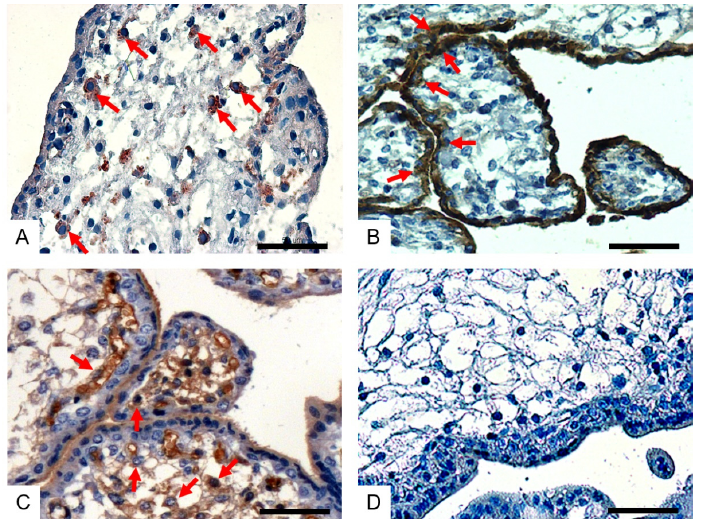
Figure 1. The distribution of AIV-Rs and HuIV-Rs in the human placenta. The placenta tissue samples were stained with biotinylated Sambucus nigra agglutinin (SNA, for HuIV-R) ( A ), biotinylated Maackia amurensis lectin I (MAA I, for AIV-R) ( B ) and biotinylated Maackia amurensis lectin II (MAA II, for AIV-R) ( C ). A section incubated with PBS was used as a negative control ( D ). All sections were counterstained with hematoxylin. The arrows indicate positive cells. Scale bar = 50 μ M. The SDS immunohistochemistry method was performed further, to identify the cell types of these positive cells. We found that the SNA-positive cells (Figure 3A) were mac- rophages (Hofbauer cells) (Figure 3B), that the MAA I-positive cells (Figure 3C) were syn- cytiotrophoblast cells (Figure 3D) and that the MAA II-positive cells (Figure 3E) were cy- totrophoblast cells (Figure 3F). The results of the consecutive sections showed that the MAA I-positive cells were syncytiotrophoblast cells (Figure 3G,H) and that the MAA II- positive cells were vascular endothelial cells (Figure 3I,J).